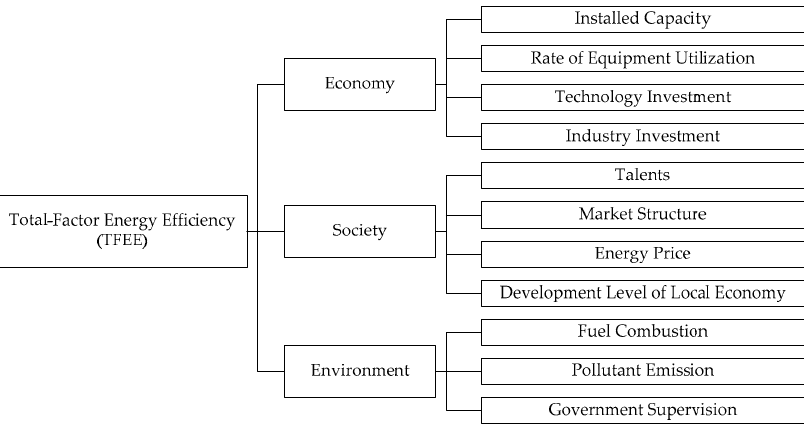
Figure 2. Influencing factors to TFEE in thermal power industry.